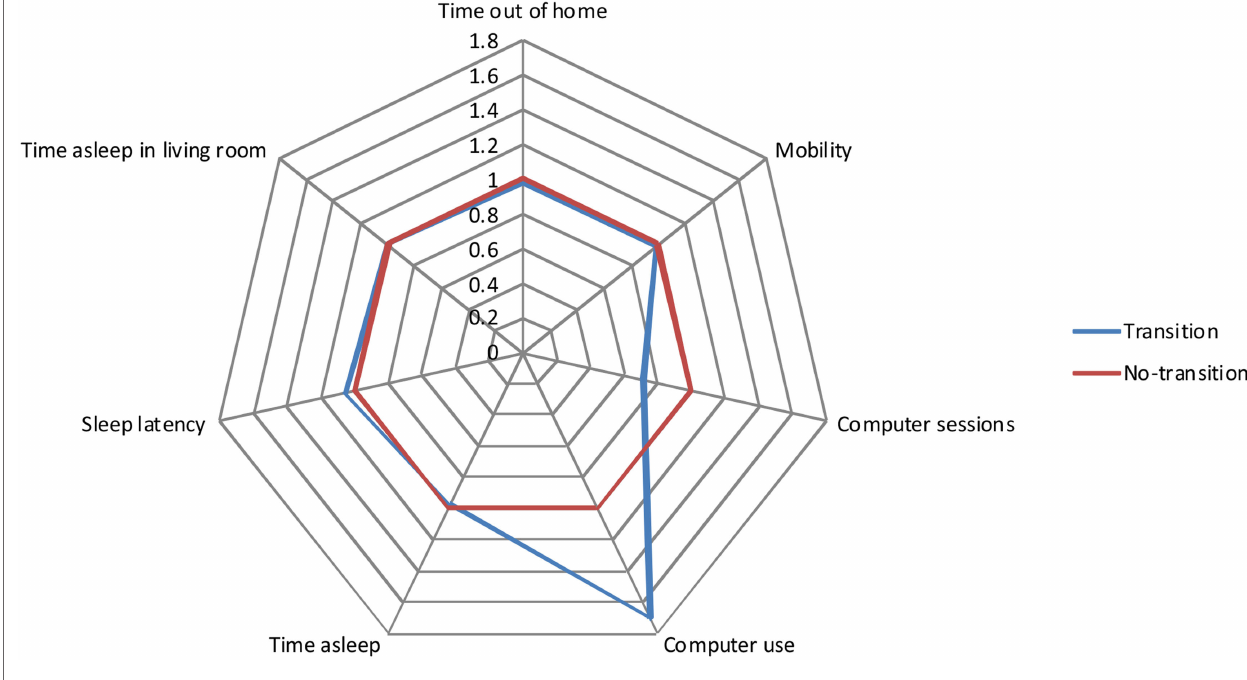
FIGURe 2 | spider plot comparing the change in the odds ratio of transitioning (blue) compared to not transitioning (red) for several in-home measured variables . This shows that computer use and sleep are especially important in predicting an advanced care